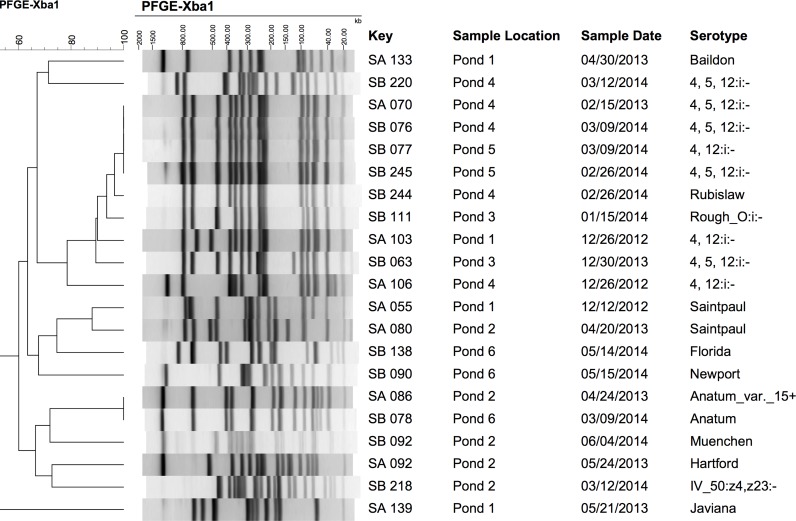
XbaI PFGE patterns for the serotyped Salmonella isolates (n = 21) collected from the six agricultural ponds in Central Florida during the two-year survey.Band sizes (kb) are displayed at the top of the PFGE pattern images. PFGE pattern order displayed is result of BioNumerics similarity analyses using the unweighted pair group-matching algorithm (UPGMA) and the Dice correlation coefficient with a maximum space tolerance of 1.5%. Key represents the isolate designation, sample location the pond number, sample date the month/year of sample collection, and serotype.